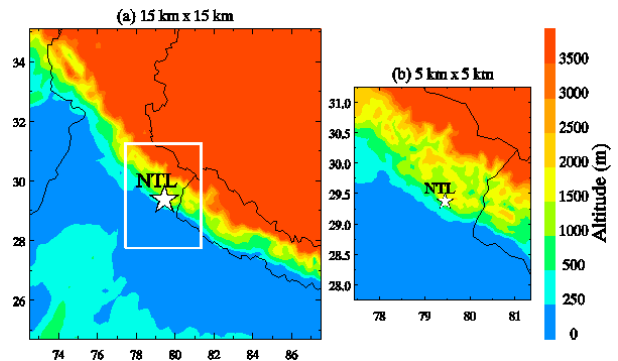
Figure 2. The WRF simulation domains used in the study are shown. The coarser domain (15km × 15km) simulations are used to drive the simulation over the nested domain shown as white box in panel (a) and separately in panel (b) . The geographical topog- raphy of the region and the location of measurement site Nainital (NTL) are also